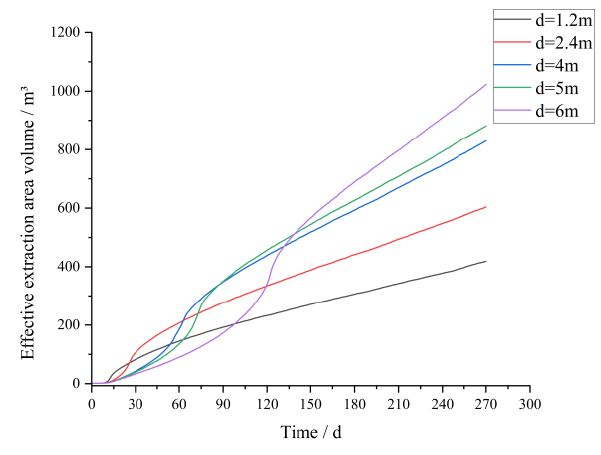
Figure 8. The volume change in effective extraction area under different extraction spacing at 140 d. Table 2. Table of parameters required for simulation.